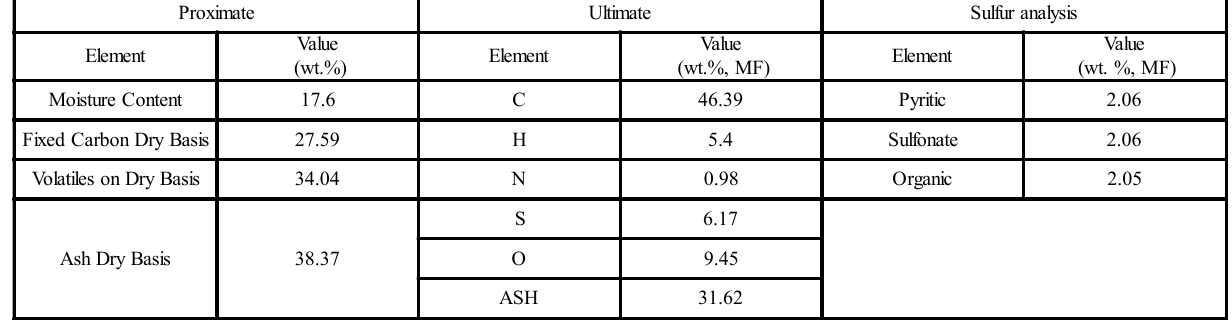
TABLE 3. PROPERTIES OF SONDA COAL FIELD